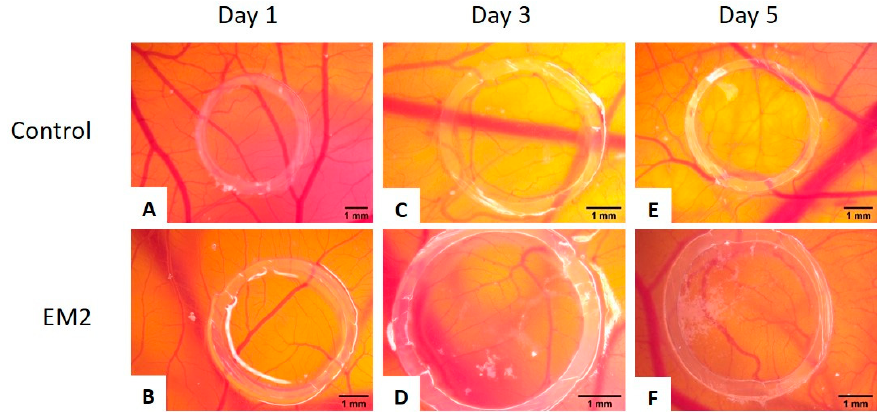
Figure 5. Normal chick chorioallantoic membrane-angiogenesis evaluation of EM2; suggestive stereomicroscopic images were registered on day 1 ( A , B ), 3 ( C , D ) and 5 ( E , F ) of the experiment: control containing only 1% dimethyl sulfoxide (DMSO) ( A , C , E ) and 100 µM EM2 ( B , D , F ) [29].